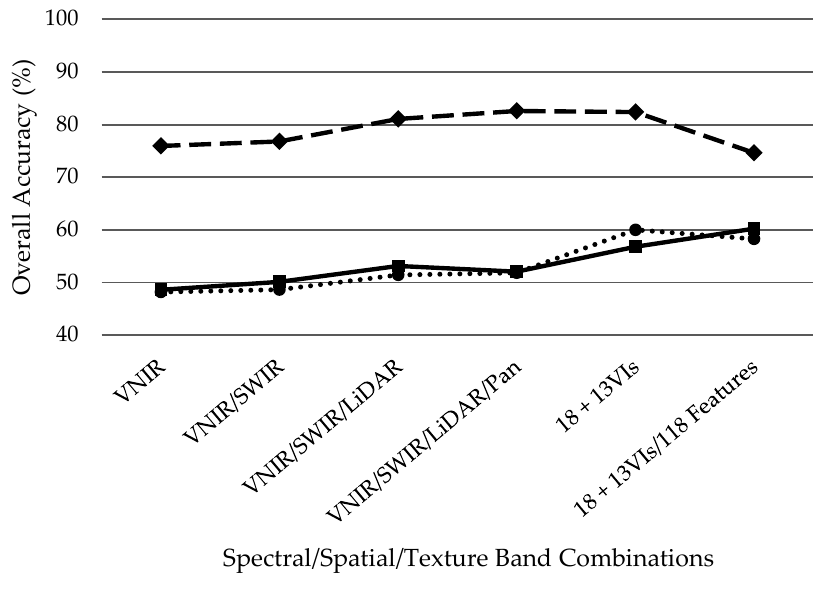
Figure 6. Overall accuracies for SVM, RF and DenseNet classifiers using various dataset combinations.